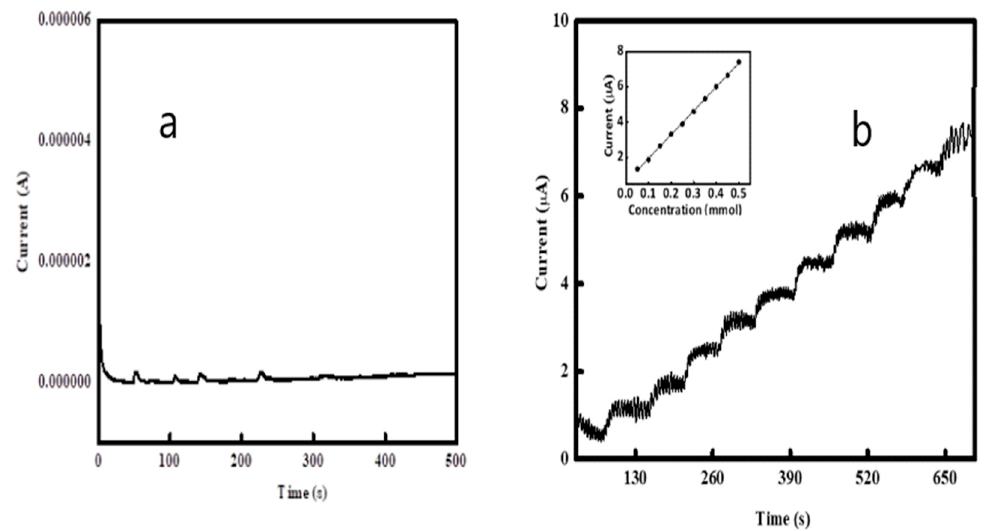
Figure 9. Chronoamperometry of ( a ) a bare Au-disc and ( b ) a PANI modified electrode recorded upon sequential addition of AA (0.05 mM) in 0.1 PBS (pH = 4) at a constant voltage of 0.24 V. Inset: dependence of current on AA concentration.